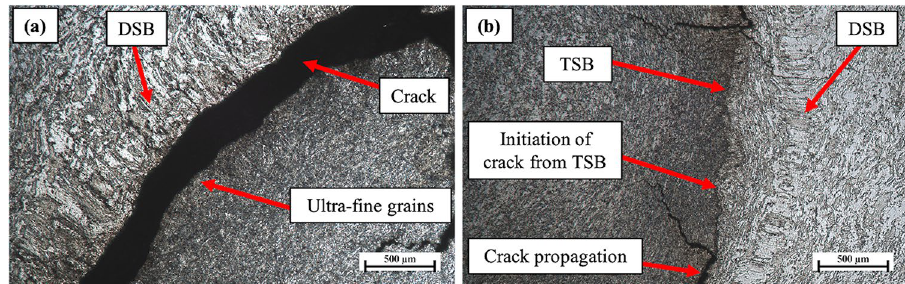
Fig. 11 OM images of speci- men deformed with 4900 s −1 at 400 °C showing ( a ) crack propagation and ( b ) crack initiation with the presence of ASBs alongside